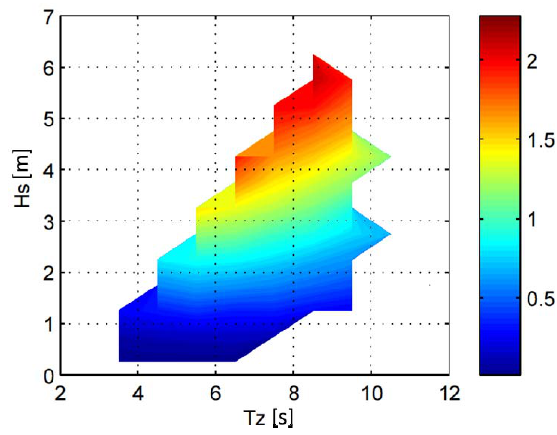
Figure 4. Scatter diagram of the Lifesaver